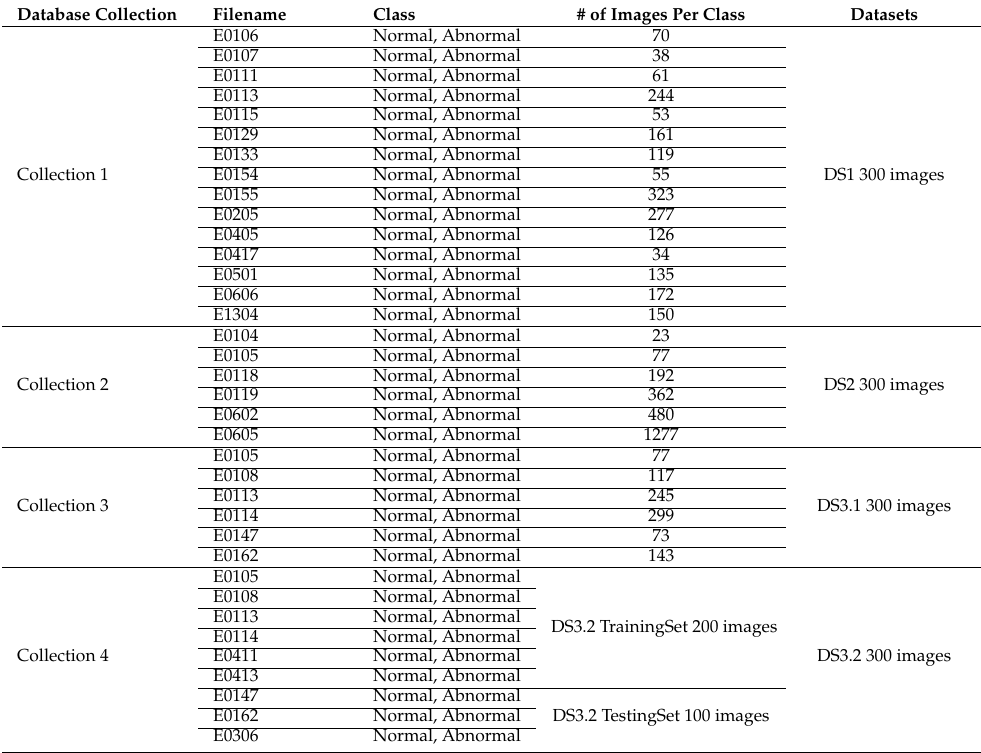
Table 1. Database collection and dataset